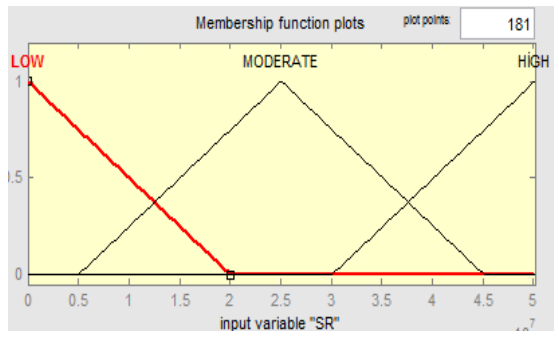
Figure 5. Sales Income Membership Range Sales income triangle membership function